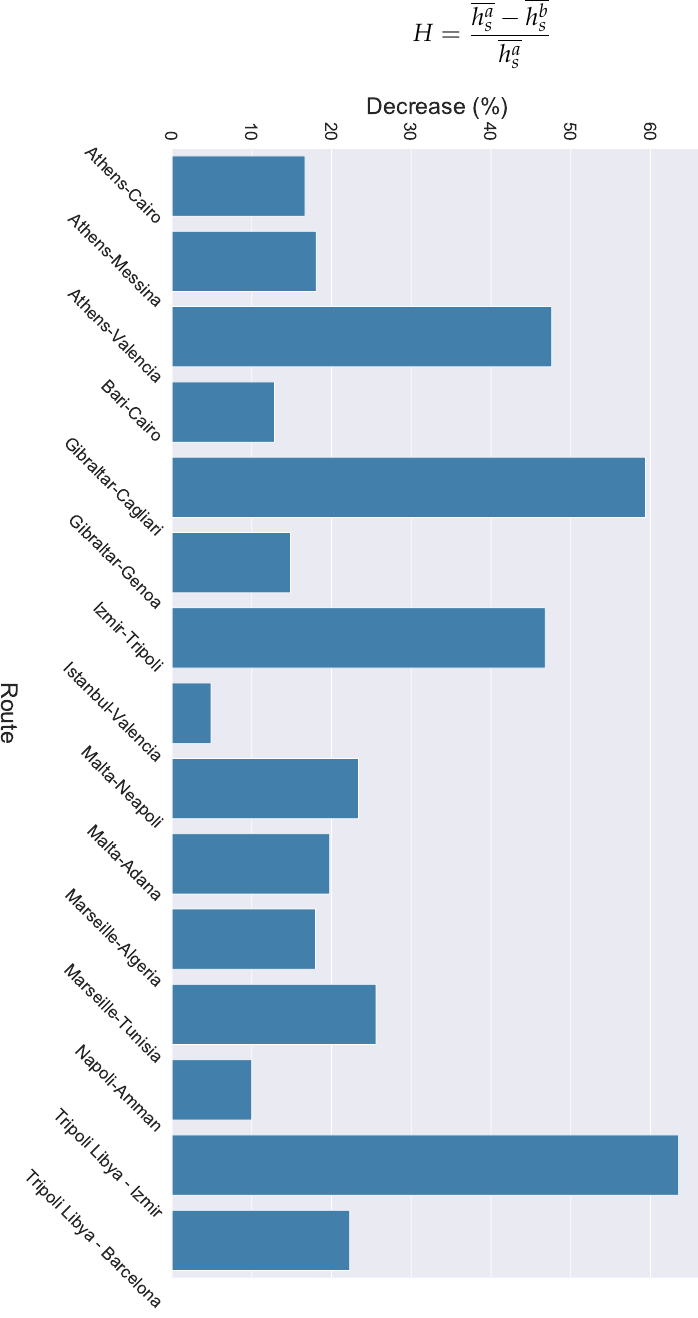
Figure 6. Decrease of the wave height when the alternate routes are